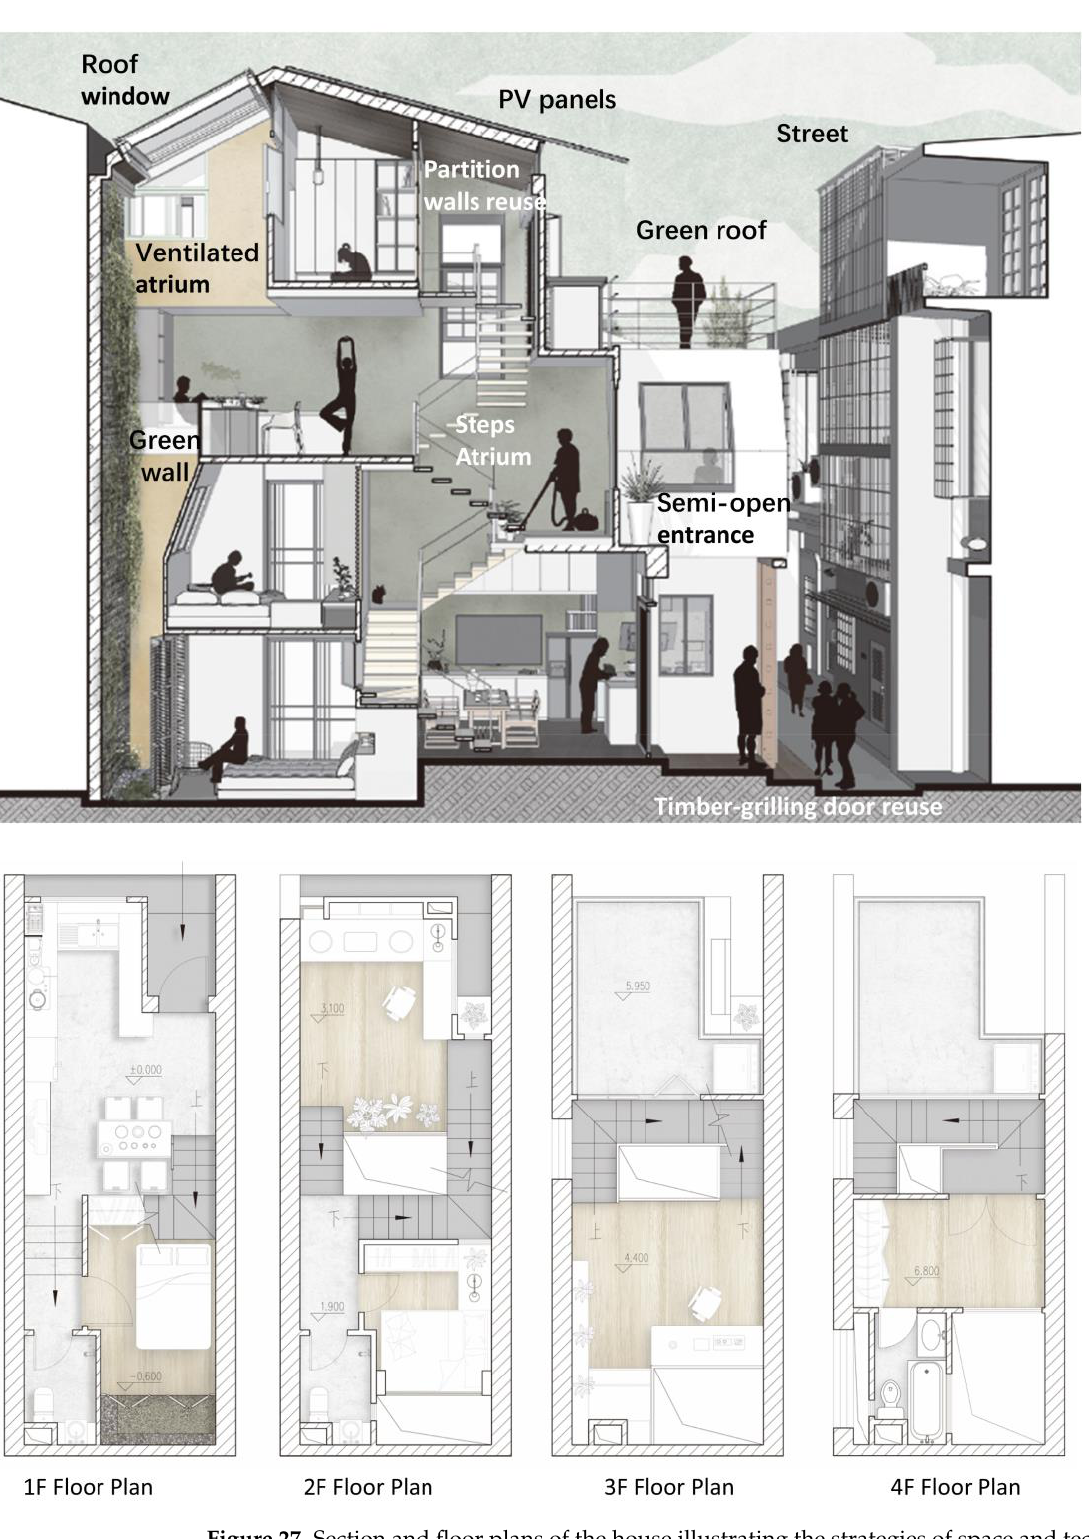
Figure 27. Section and floor plans of the house illustrating the strategies of space and technologies (drawn by the students).